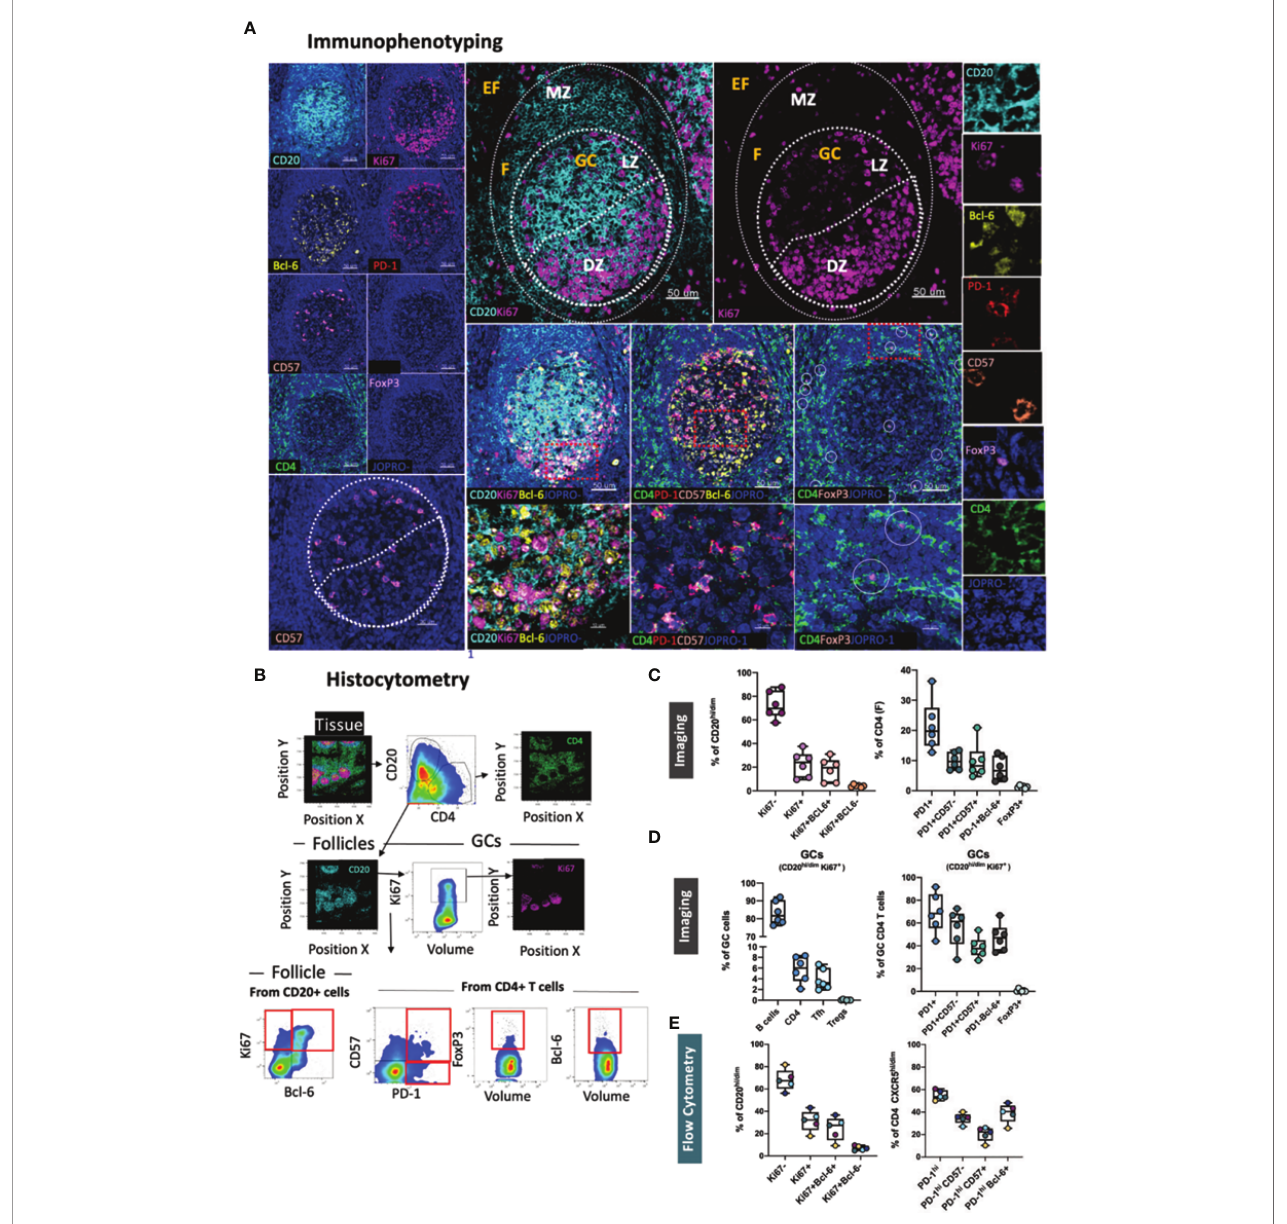
FIGURE 1 | Development of a multispectral panel for the characterization of GC reactivity. (A) Representative example of Ki67 (magenta), CD20 (cyan), PD-1 (red), Bcl-6 (yellow), CD57 (orange), CD4 (green) and FoxP3 (pink) staining patterns in a tonsillar tissue section (left and right panels) and concomitant B-cell follicle and GC boundary delineations (Extrafollicular CD20lo and Follicular CD20hi/dim; Mantle Zone; MZ: CD20dimKi67lo, Light Zone; LZ: CD20hiKi67lo and Dark Zone; DZ: CD20dim Ki67hi) (middle panel). Circles in lower middle panels denote single FoxP3 events. (B) Histocytometry immunophenotyping gating strategy used for the sequential identi fi cation of B cells (CD20+Bcl-6+/- Ki67+/-), Tfh (CD4+PD-1hiBcl-6+/- CD57+/-), and Tfr (CD4+FoxP3+) in tonsillar tissue after nuclear staining based cell segmentation on Imaris and FlowJo analysis. F and EF and GC areas were de fi ned based on the respective staining signals for CD20, Ki67 and CD4 and manually gated on FlowJo to extract frequencies for speci fi c tissue localities. (C) Box plots showing the representative frequencies of B cell and CD4+ T-cell populations (Tfh, Treg) in B-cell follicles (CD20 hi/dim areas) as de fi ned by the expression of Ki67/Bcl-6, PD-1/CD57/Bcl-6 and FoxP3 in tonsillar tissue after application of the GC reactivity pipeline. Each box plot circle represents an individual follicle. Colors represent different phenotypic groups. (D) Box plots showing the relative frequencies of B-cells, CD4 T cells, Tfh and Tregs (Tfr) as well as the frequencies of select CD4 T cell subpopulations in GCs (CD20 hi/dim Ki67+ areas) expressed as percentages of total GC cells measured. Circles represent distinct follicles and colors denote individual subpopulations. (E) Box plots showing the relative frequencies of B cell and CD4+ T-cell populations in B-cell follicles as measured by fl ow cytometry (n=5). CD4 T cells proximal to follicular localities and within GCs were identi fi ed through the expression of the B-cell follicle-speci fi c chemokine receptor CXCR5 (CXCR5 hi/dim ). Images were acquired at 40x (NA 1.3) with 1% magni fi cation. Scale bars are 50um, 30um (CD57 positional image) and 10um (lower panel zoomed details)